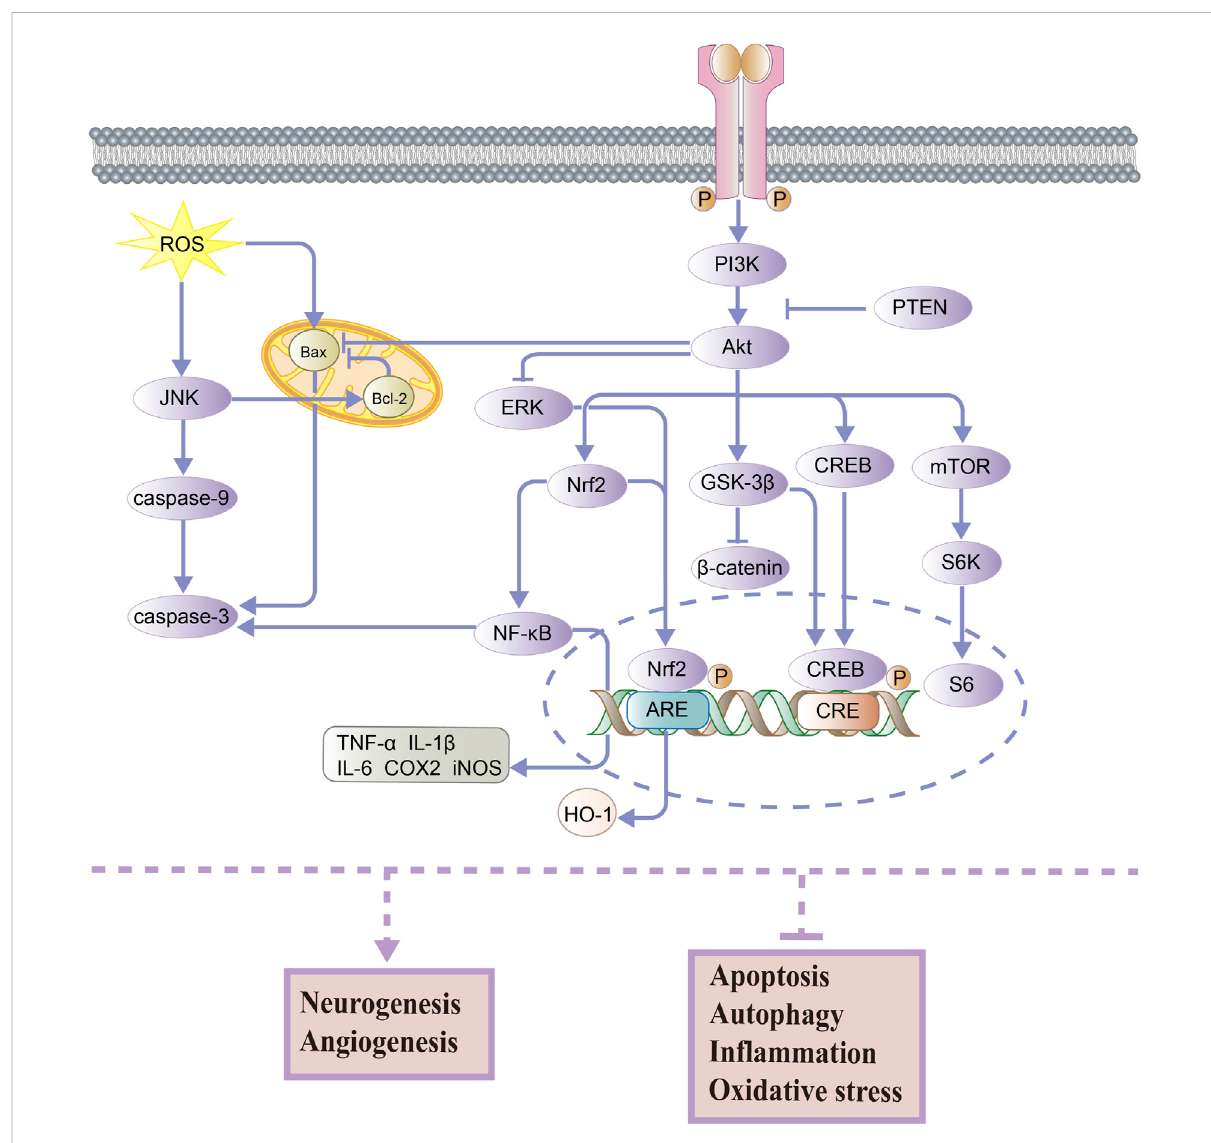
FIGURE 1 PI3K/Akt signaling pathway for